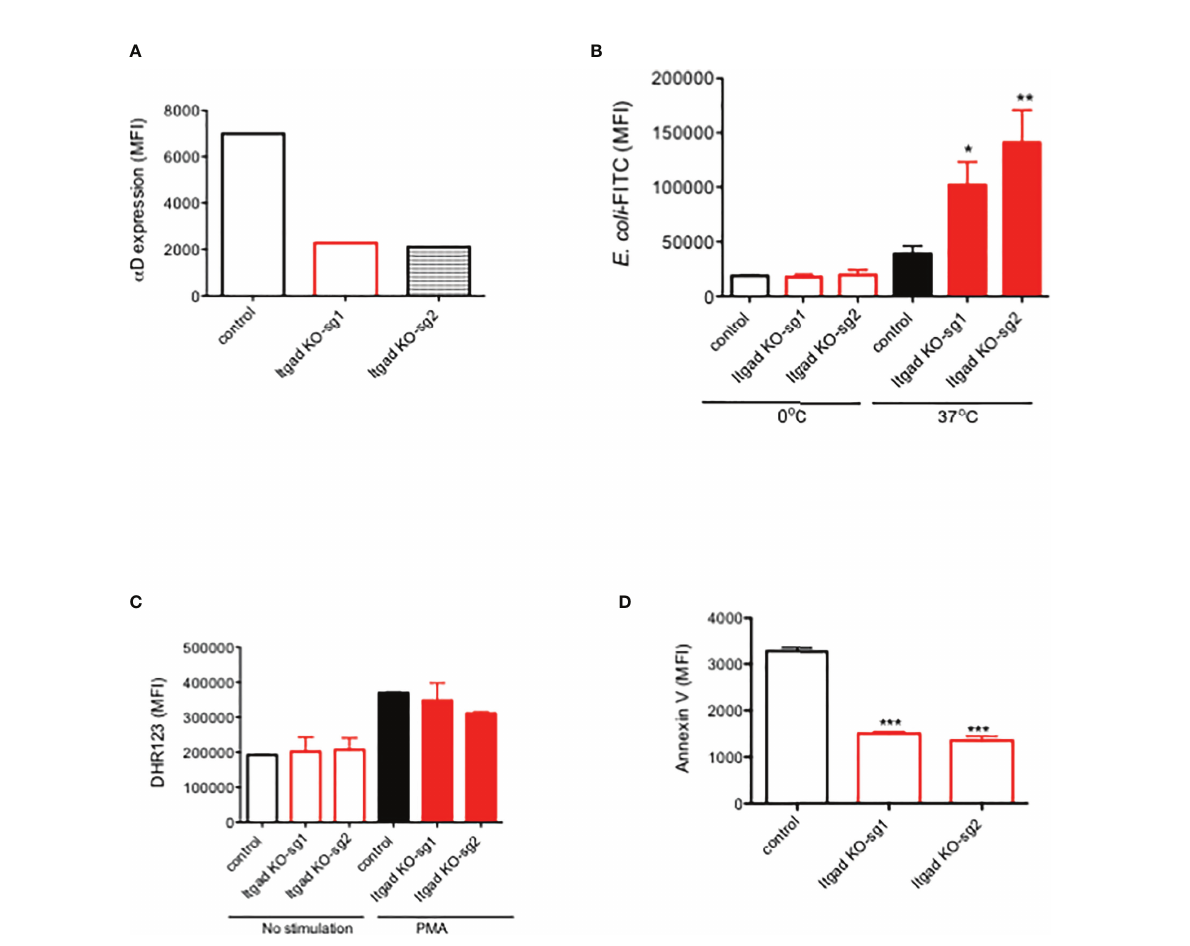
FIGURE 4 The role of a D b 2 in human HL60 cells. (A) a D expression of HL60 cells with or without a D CRISPR/Cas9 deletion. Representative data was shown. (B) Phagocytosis, (C) ROS, and (D) Annexin V expression of HL60 cells with or without a D CRISPR/Cas9 deletion. Data were shown as mean +/- S.D. of triplicates. Sg1 and sg2 denote two different guide RNA. One-way ANOVA with Bonferroni post hoc analysis was performed. *P < 0.05, **p < 0.01, ***p <